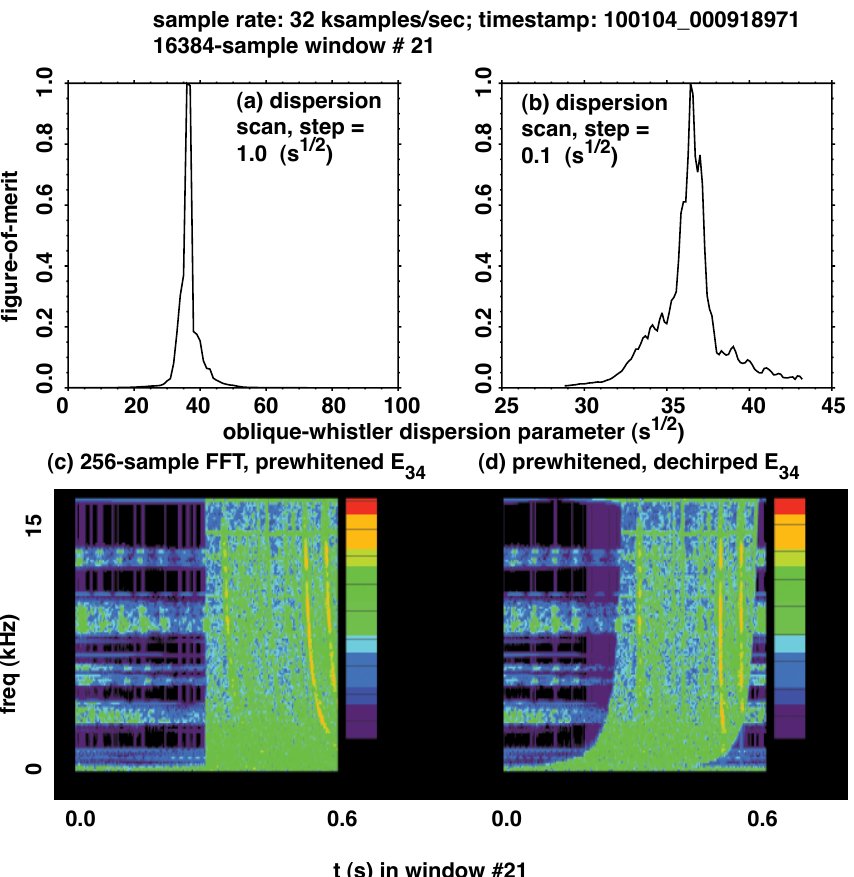
Fig. 2. Example of dispersion and peak-finding analysis, using the 21st window of the record in Fig. 1 above. The window contains 16384 samples, of which the first 8192 are set to zero before processing. The data in this modified window is then Fourier-transformed, pre-whitened, and dechirped against an oblique-whistler dispersion relation. (a) Figure-of-merit for dechirp vs. preliminary grid of 101 dispersion constants, from 0 to 100s 1 / 2 in steps of 1s 1 / 2 . (b) Iterated figure-of-merit for a grid of 101 values of the dispersion